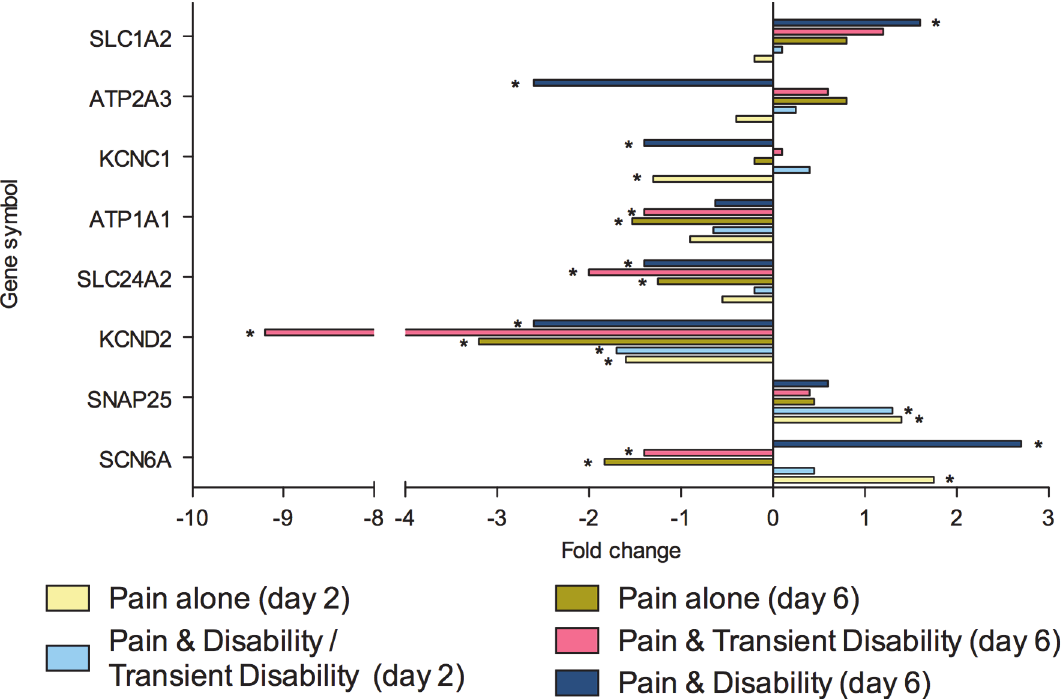
Fig 6. Gene transcripts, which encode for proteins involved in ionic balance, that are specifically regulated in the lumbar spinal cord after CCI, as determined by microarray analysis. Changes in gene expression have been tested at both 2 and 6 days after CCI on pooled mRNA samples from each disability group, compared to uninjured controls. * Indicates up- or down-regulation determined by MAS v5.0.